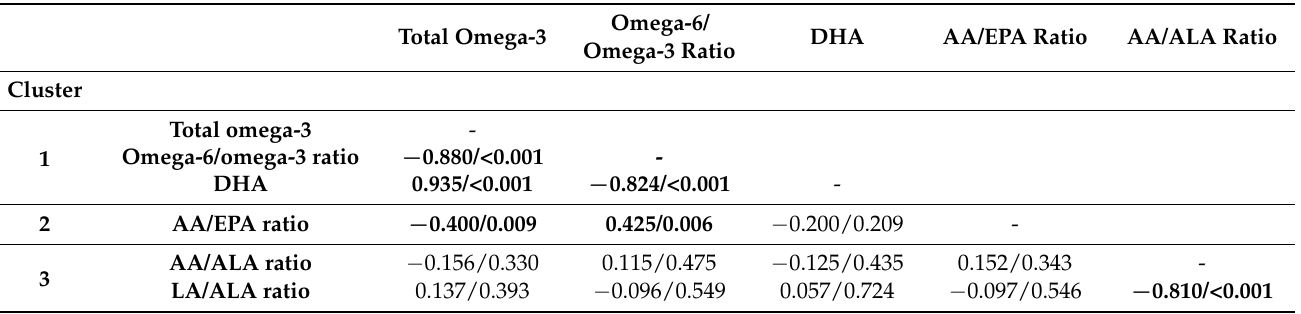
Table A1. Pearson’s partial correlations (controlling for age) of PUFAs in the blood and identification of the three clusters of inter-related variables ( n = 42). Reported values are Pearson’s correlation index r/ p -value. In bold, significant